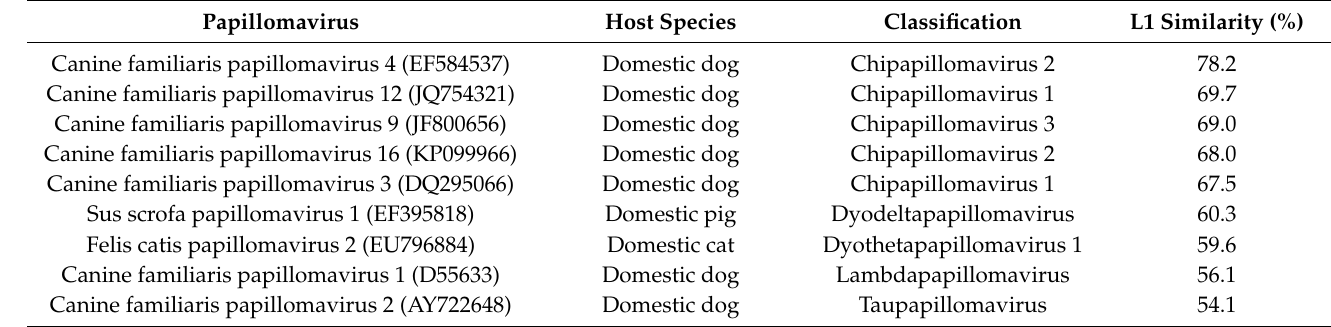
Table 2. Percent identity between the proposed CPV24 and other papillomaviruses based on the pairwise nucleotide alignments of the papillomavirus ORF L1 . The alignments were performed using MAFFT in Geneious v10.2.6 using default